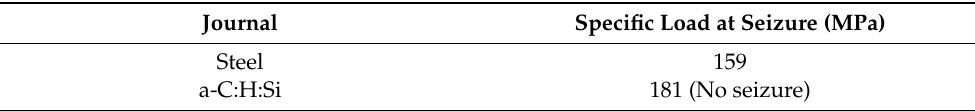
Table 8. Specific load at conclusion of seizure